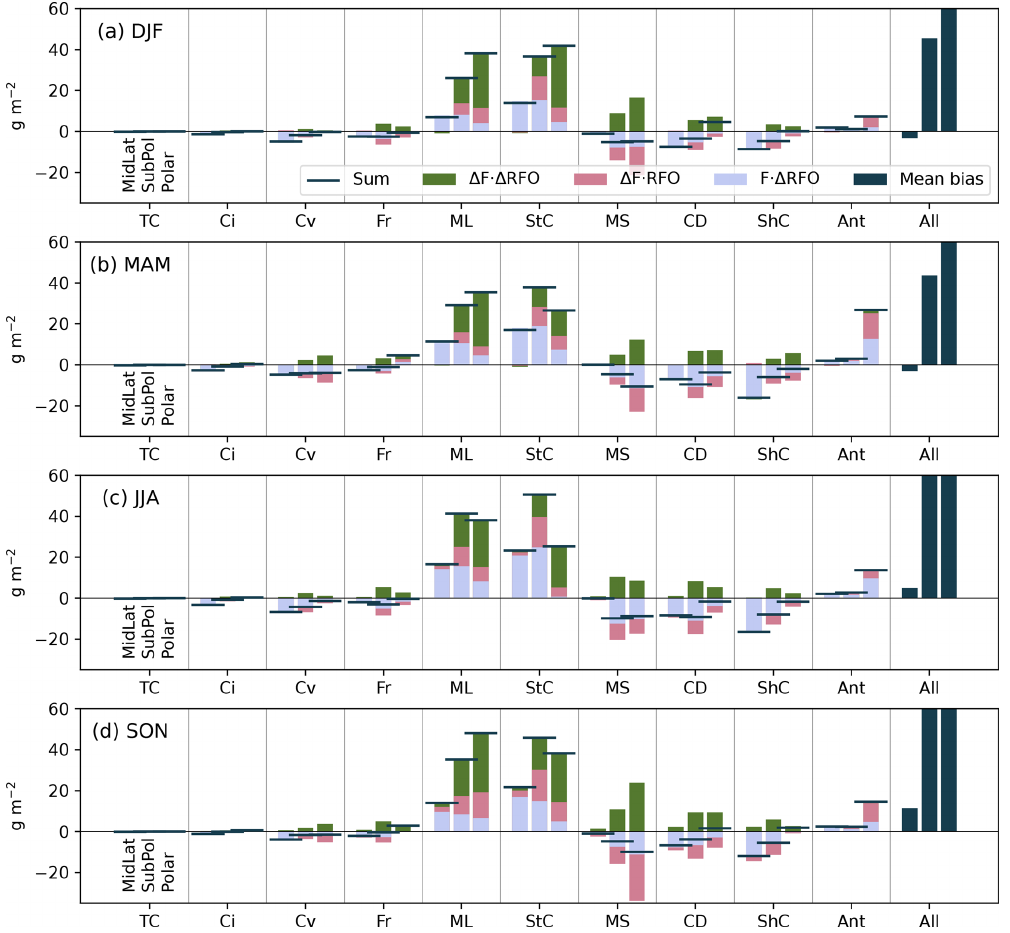
Figure A4. The decomposed mean biases in the IWP (gm − 2 ) for each cloud regime (thin cirrus, TC; cirrus, Ci; convective, Cv; frontal, Fr; mid-level, ML; stratocumulus, StC; marine stratiform, MS; cloud decks, CD; shallow cumulus, ShC; Antarctic, Ant) over the three regions from left to right mid-latitudes, sub-polar and polar, for each season (DJF, a ; MAM, b ; JJA, c ; SON, d ). The sum of the decomposed biases is shown by the horizontal bar, while the terms of the bias decomposition (see Eq. 1) are shown in blue ( F sat r · (cid:49) RFO r ), pink ( (cid:49)F r · RFO sat r ) and green ( (cid:49)F r · (cid:49) RFO r ). On the far right of each plot is the mean radiative bias for each region/season as a